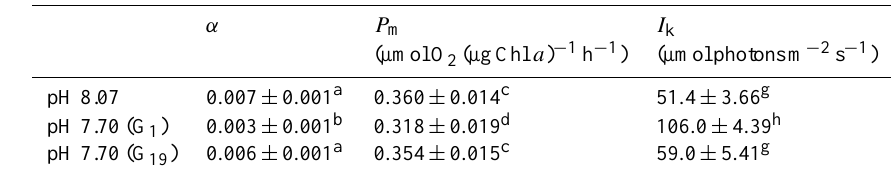
Table 3. The photosynthetic light-harvesting efficiency ( α) , maximum photosynthetic rate ( P m ) and light saturation point ( I k ), derived from light-response curves for P. globosa cells incubated in either pH 8.07 or pH 7.70 (induced by high CO 2 ) cultures. The cells were grown in pH 8.07 culture for about 9 generations and in pH 7.70 (induced by high CO 2 ) culture for 1 generation ( G 1 ) or 19 generations ( G 19 ) under an irradiance of 200µmol photonsm − 2 s − 1 before the light-response curve was measured. Superscripts with different letters indicate significant differences between groups. The data represent the mean ± SD ( n = 3, triplicate